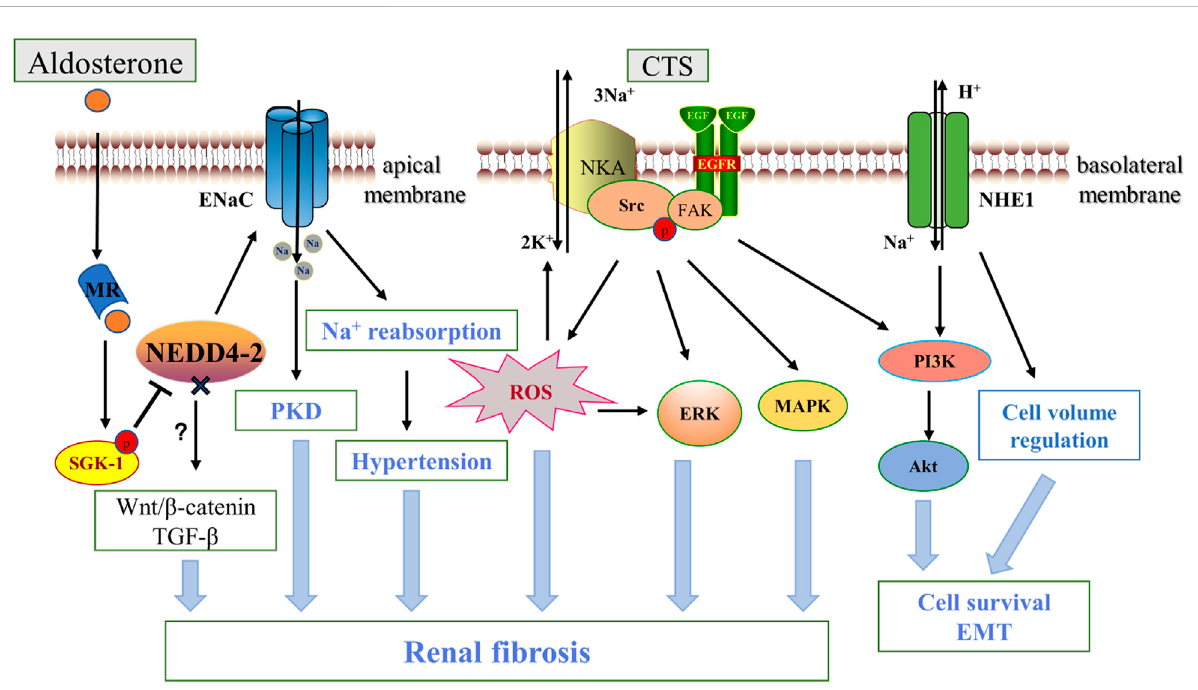
FIGURE 3 ENaC, NKA, NHE1 and renal fi brosis. Aldosterone binds to the intracellular salt corticosteroid receptor (MR), induces the expression of Na + transport regulators such as SGK1, and phosphorylation inhibits NEDD4-2, which ubiquitinates and degrades ENaC. Increased ENaC activity contributestoPKDdiseaseprogressionandaffectsbloodpressurethroughNa + reabsorption,andNEDD4-2de fi ciencyalsopromotes fi brosis via the Wnt/ β -cateninandTGF- β pathways.Na + ,K + -ATPaseactsasascaffoldingproteinthatinteractswithCTStoactivateSrcandthentrans-activates EGFR involving a cascade reaction leading to reactive oxygen species generation, which leads to downstream activation of ERK, AKT, MAPK in addition to further activation of NKA. NHE1 promotes renal tubule survival through PI3K/Akt and regulation of cell volume. In addition, ENaC is located in the apical membrane, while NKA and NHE -1 are mainly located in the basolateral membrane. CTS, cardiotonic steroids; PKD, polycystic kidney disease; EGFR, epidermal growth factor receptor; FAK, focal adhesion kinase; FAK, focal adhesion kinase; ERK, extracellular-signal-regulated kinase; MAPK, mitogen-activated protein kinase; PI3K, Phosphatidylinositol